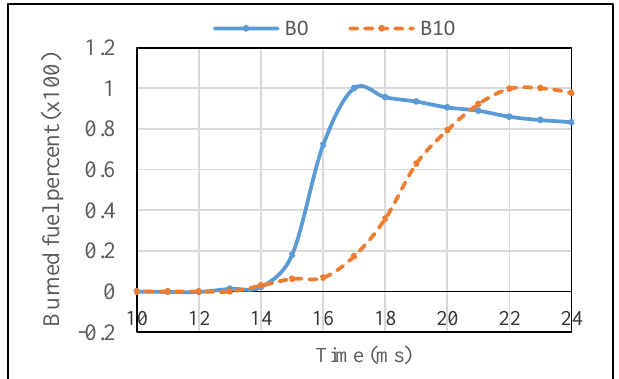
Figure 9. Graph of the % fuel burned.